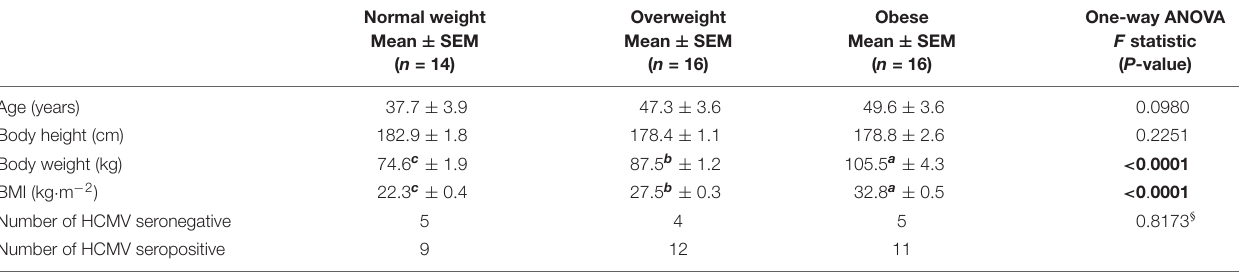
TABLE 1 | Characteristics of the human study